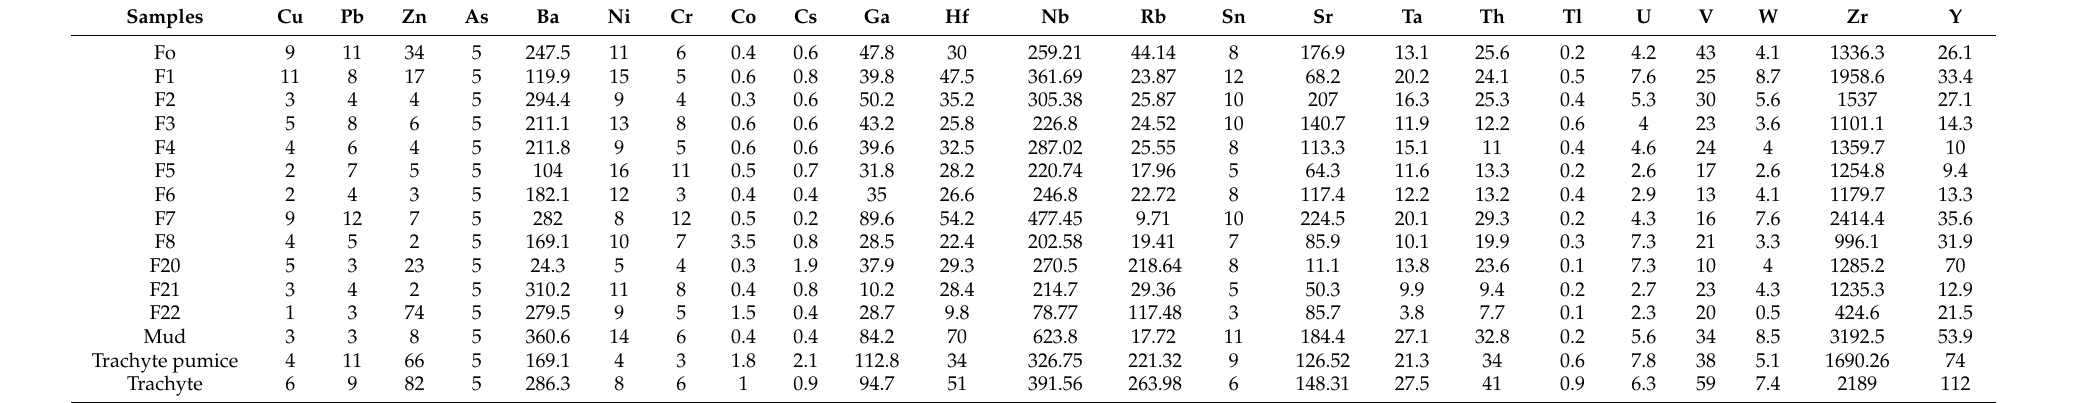
Table 3. Trace elements concentration (ppm) of the analyzed